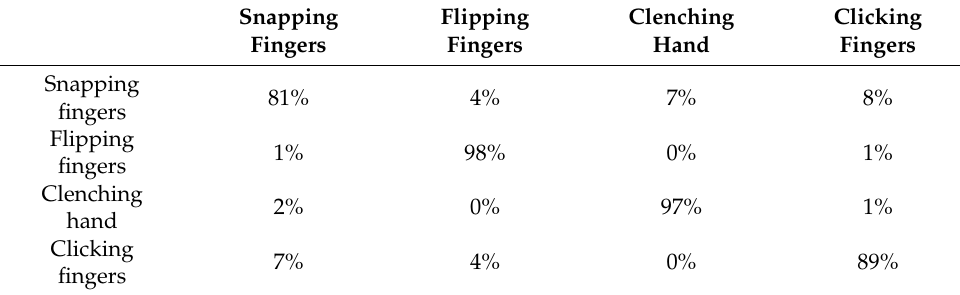
Table 1. Confusion matrix of the proposed method.